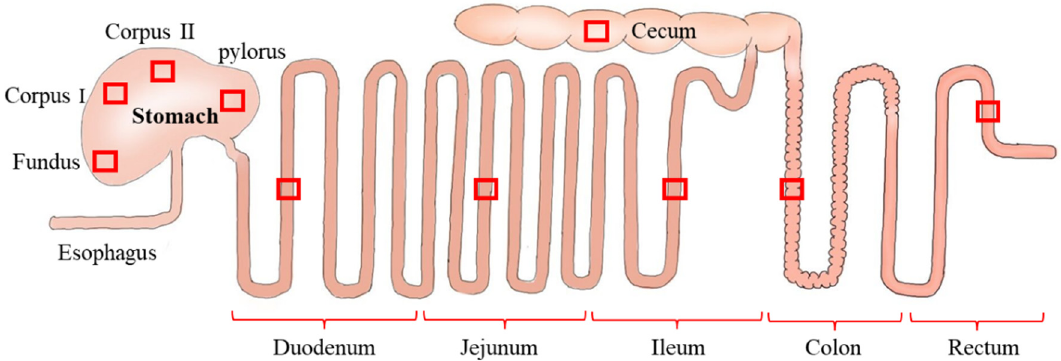
Figure 1. Schematic diagram of gastrointestinal organs of small mammals. The site of tissue harvest- ing is indicated by red squares for histological observation and measurement of the GIT.